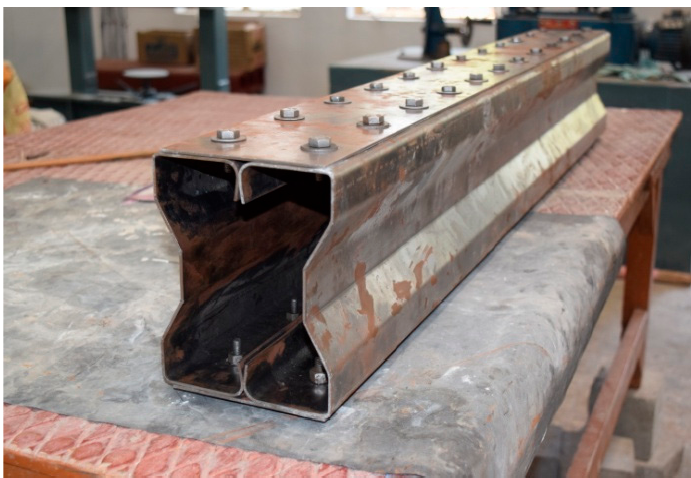
Figure 8. CFS beam specimens before testing cold-formed built-up